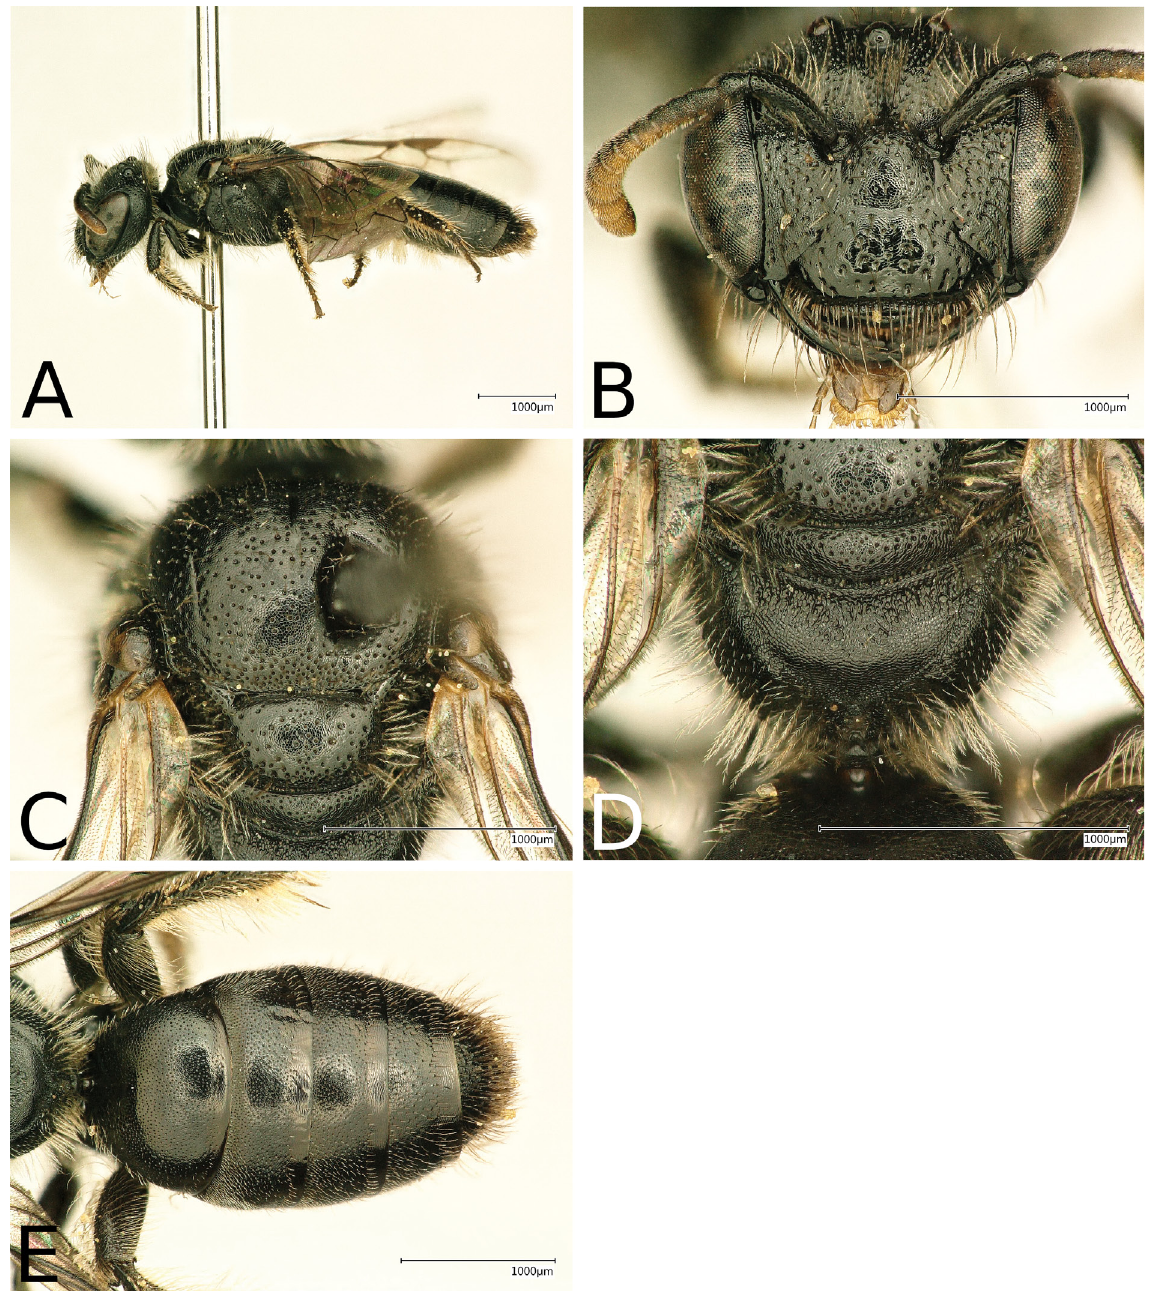
Fig. 5. Scrapter keiskiensis Kuhlmann sp. nov., ♀, holotype (RCMK). A . Lateral view. B . Head. C . Scutum and scutellum (dorsal view). D . Metanotum and propodeum (dorsal view). E . Metasoma (dorsal